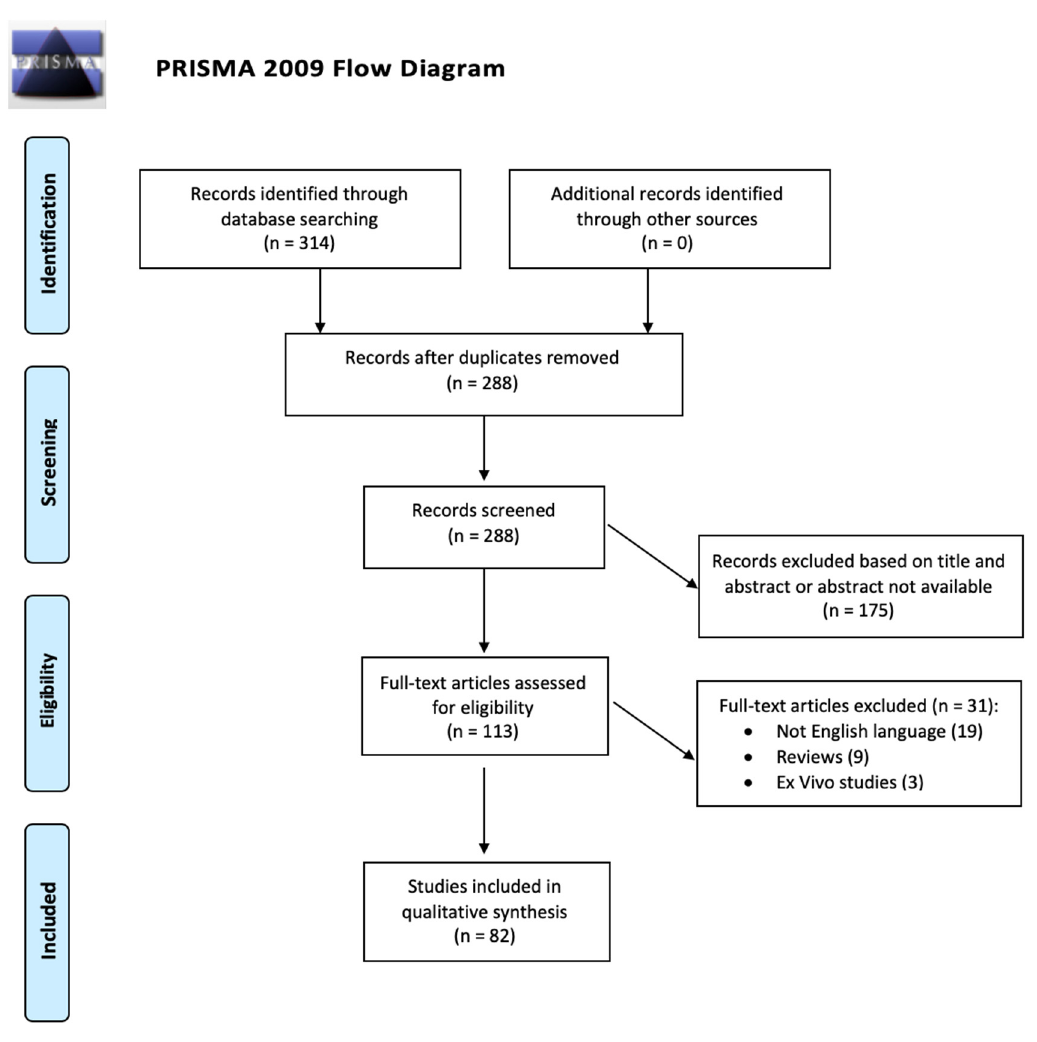
Figure 2. Preferred reporting items for systematic reviews and meta-analyses (PRISMA) flowchart.